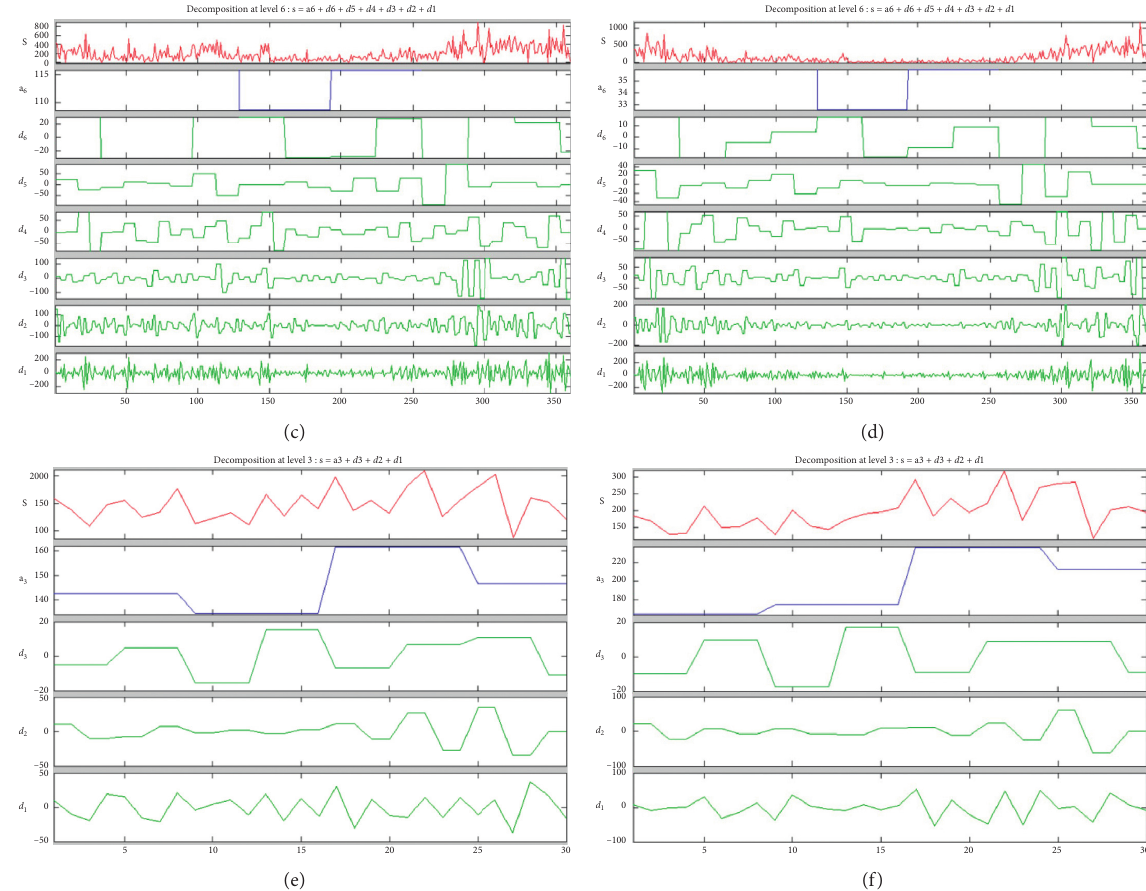
Figure 5: Discrete wavelet transform results for monthly rainfall: (a) for Badulla (monthly); (b) for Ledgerwatte Estate (monthly); (c) for Lower Spring Valley (monthly); (d) for Kandekatiya (monthly); (e) for Badulla (annual); (f) for Ledgerwatte Estate